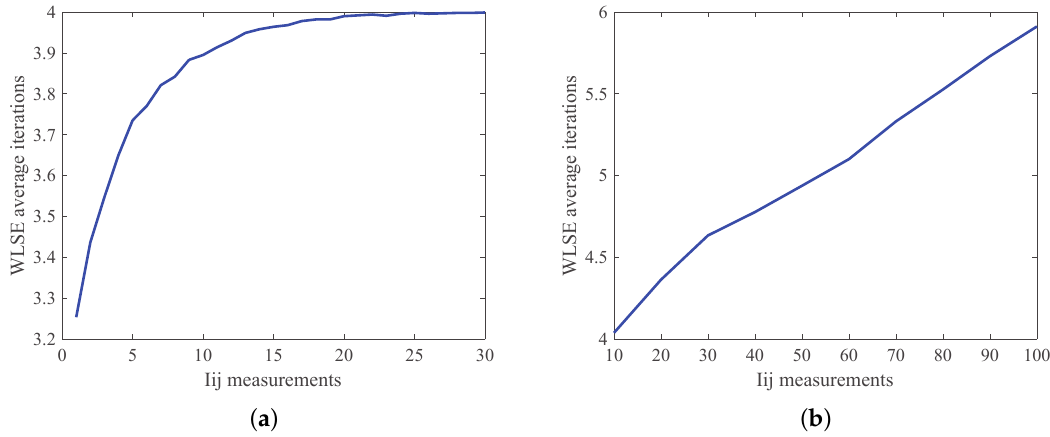
Figure 5. Average iterations of the conventional state estimator: ( a ) 85-bus system; ( b ) 117-bus system.